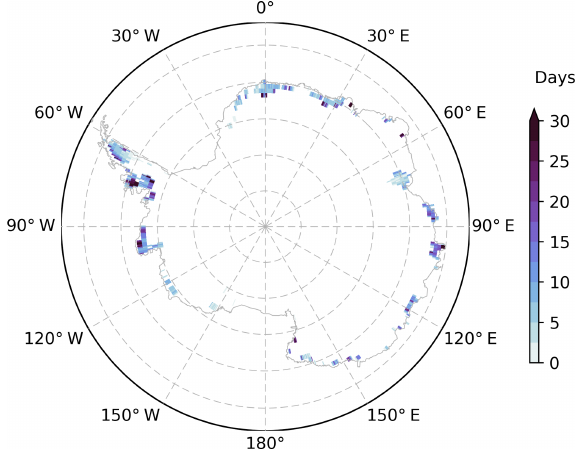
Figure 6. Mean melting days by summer season detected as melting at 1.4GHz but dry at